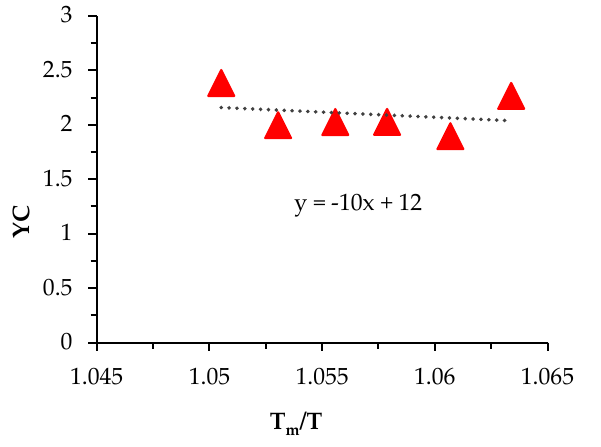
Figure 9. Analysis of the sintering activation energy within the Young–Cutler model on the example of the II ‐ 5 sample.